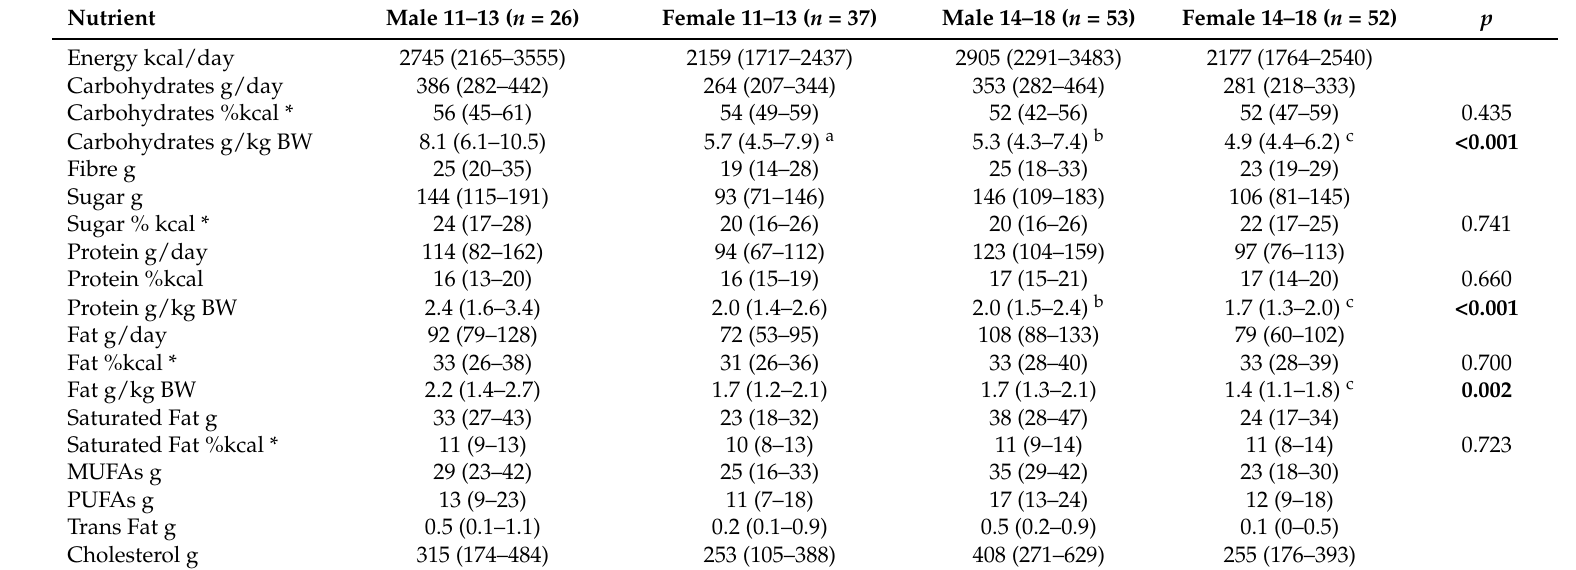
Table 2. Reported energy and macronutrient